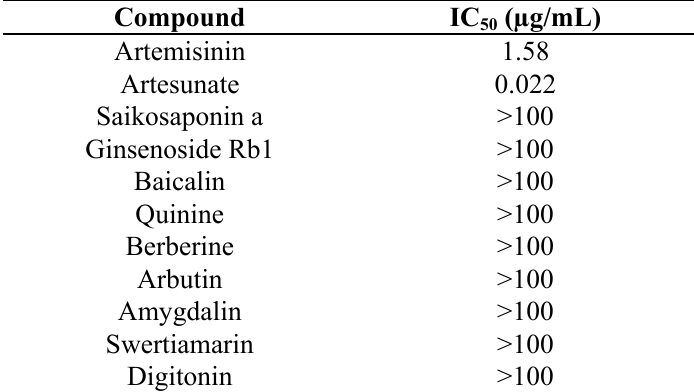
Table 2. Cross-reactivities of anti-AM Fab against various natural